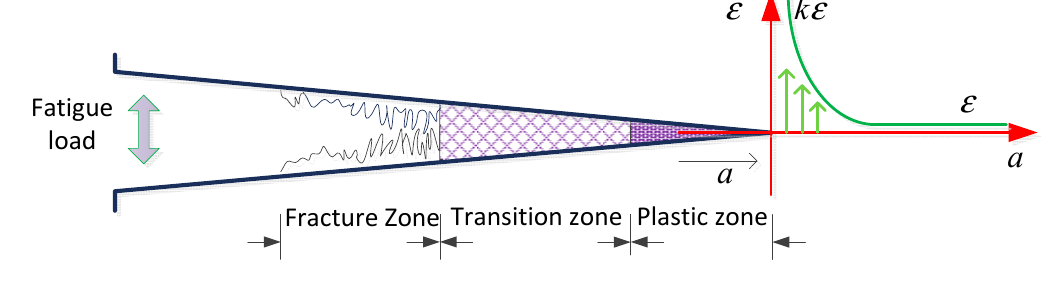
Figure 8. Illustration of strain concentration surrounding an initial fracture.